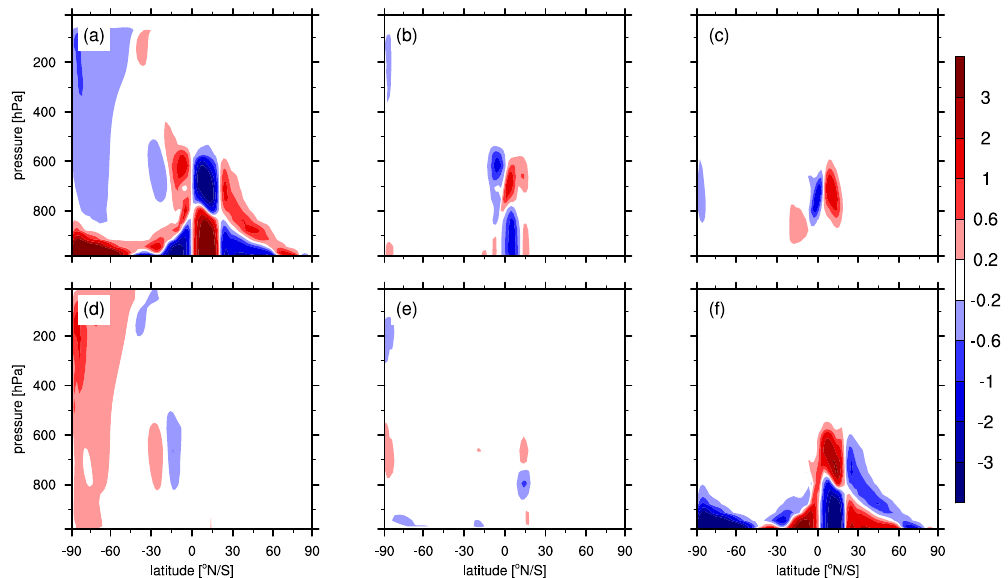
Fig. 3. Zonal-mean zonal momentum budget for perpetual off-equatorial insolation in 10 − 5 ms − 2 : (a) Coriolis force, (b) meridional advec- tion of mean relative vorticity, (c) negative of vertical advection of mean zonal momentum, (d) horizontal contribution to eddy momentum flux convergence, (e) vertical contribution to eddy momentum flux convergence, and (f) vertical diffusion of zonal momentum. The contri- butions from moist convection (i.e. cumulus friction) and horizontal diffusion are